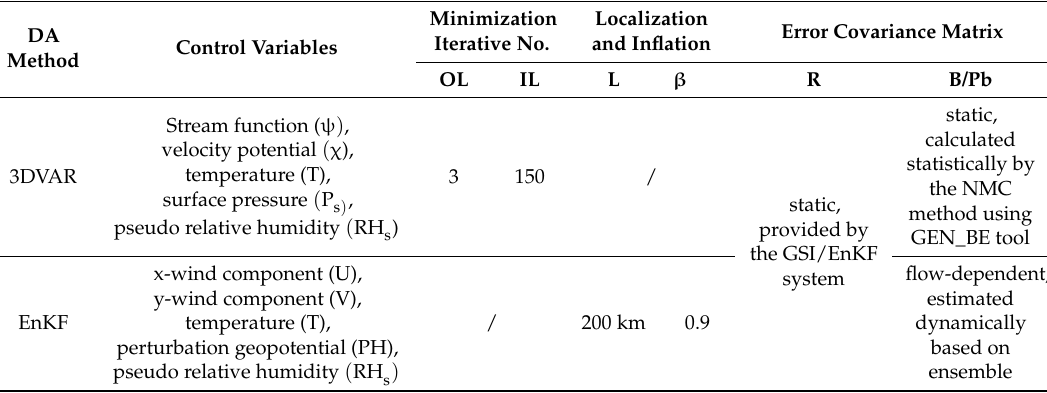
Table 2. Specifications of three-dimensional variational assimilation (3DVAR) and ensemble Kalman filter (EnKF).